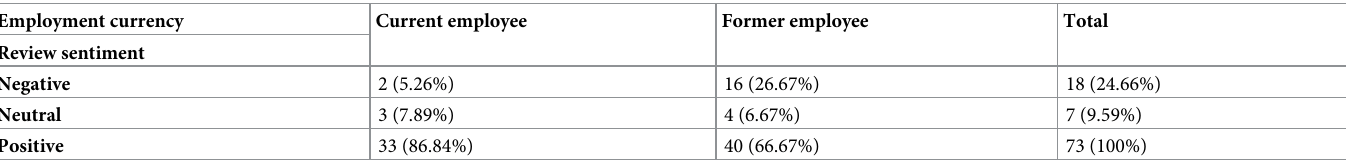
Table 7. Online staff review sentiment by former employees and current